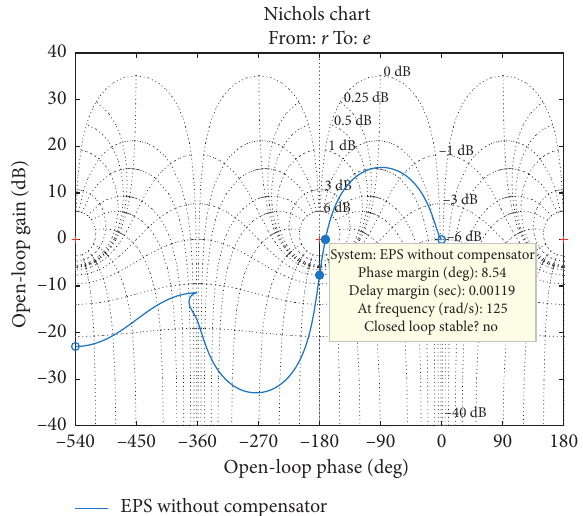
Figure 5: Nichols chart of EPS without compensator.